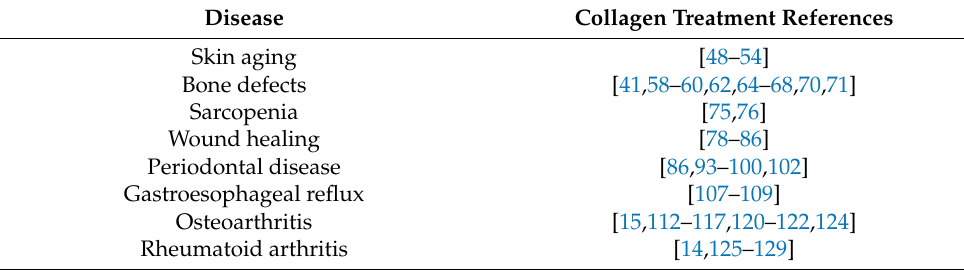
Table 2. The references of the collage